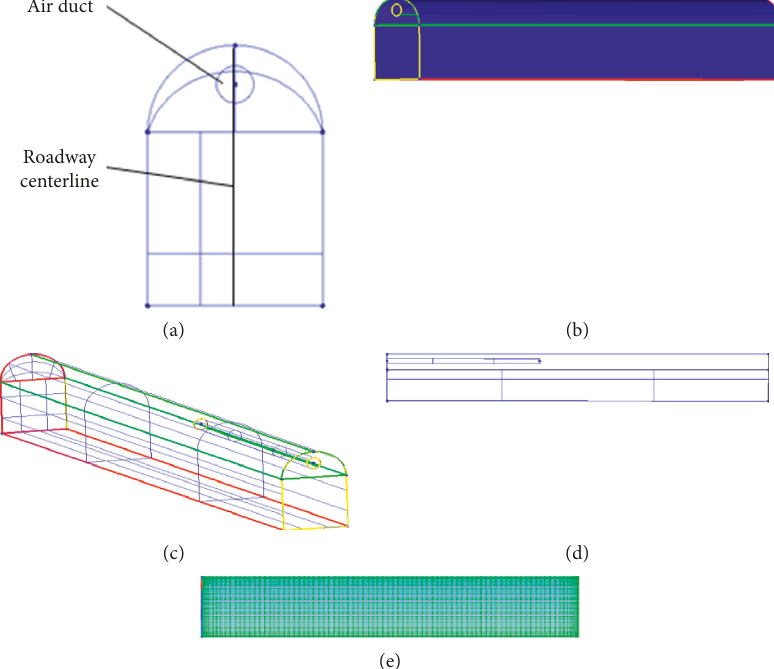
Figure 7: Three-dimensional model of a single roadway. (a) Entrance cross section. (b) 3D model diagram. (c) Unfilled color 3D model diagram. (d) Longitudinal section of roadway. (e) Mesh map. Note: the red part on the left side of Figure 7(e) is the inlet of the air duct, and the blue part is the exit area of the single